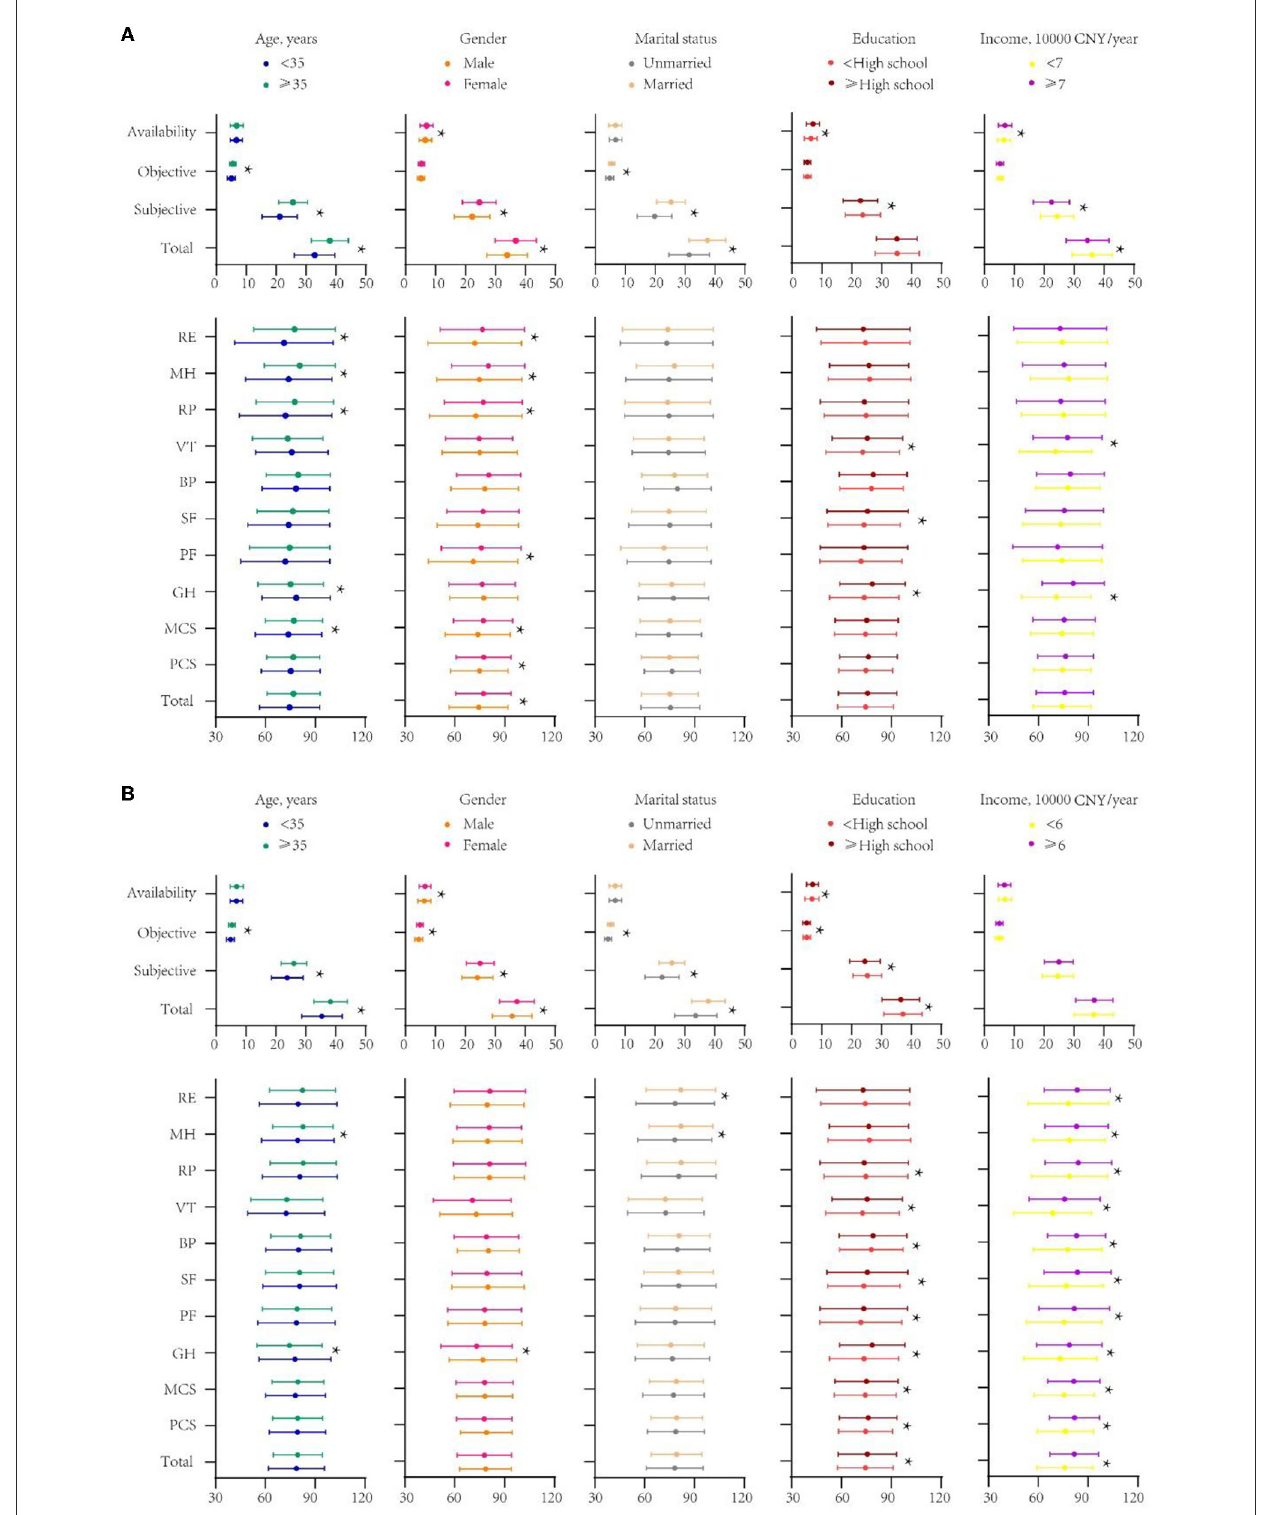
FIGURE2 (A) Scores of social support and quality of life of urban workers by different sociodemographic variables. (B) Scores of social support and quality of life of migrant workers by different sociodemographic variables. *indicates p < 0.05. CNY, China Yuan, $US1 = CNY6.95; PF, Physical functioning; RP, Role physical; BP, Bodily pain; GH, General health; SF, Social functioning; VT, Vitality; MH, Mental health; RE, Role emotional; PCS, physical component summary; MCS, mental component